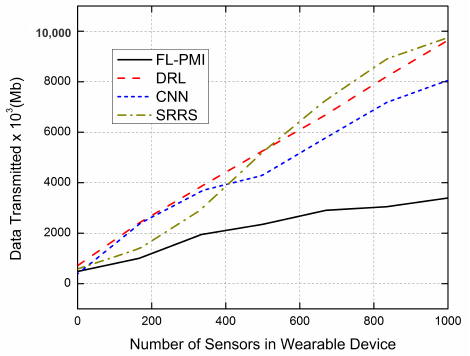
Figure 11. Comparative analysis of memory usage concerning the number of sensors in wearable devices.